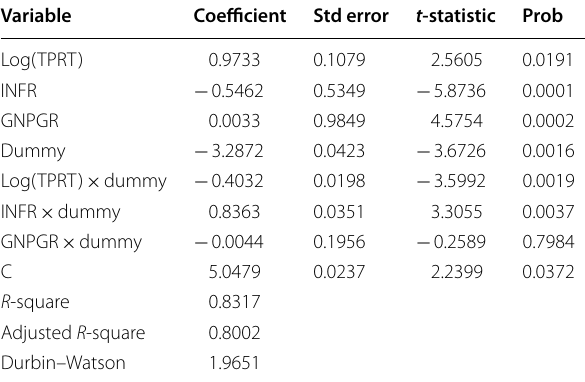
Table 5 Result of the regression